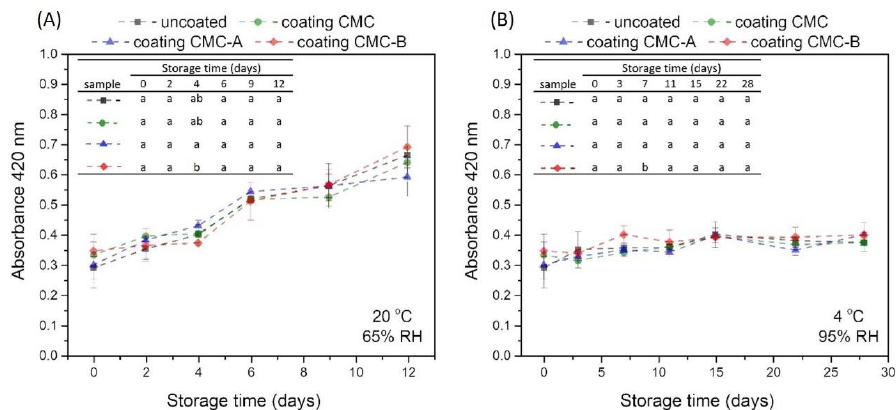
Figure 6. Browning rate of the fresh goldenberries (coated and uncoated) as a function of storing: ( A ) 20 °C and 65% RH and ( B ) 4 °C and 95% RH. Results are expressed as mean ± standard deviation ( n = 4). In the inserted table, different letters on the same analysis day correspond to statistically different values for a 95% confidence level. The browning rate to all the goldenberries uncoated and coated with CMC, CMC-A,